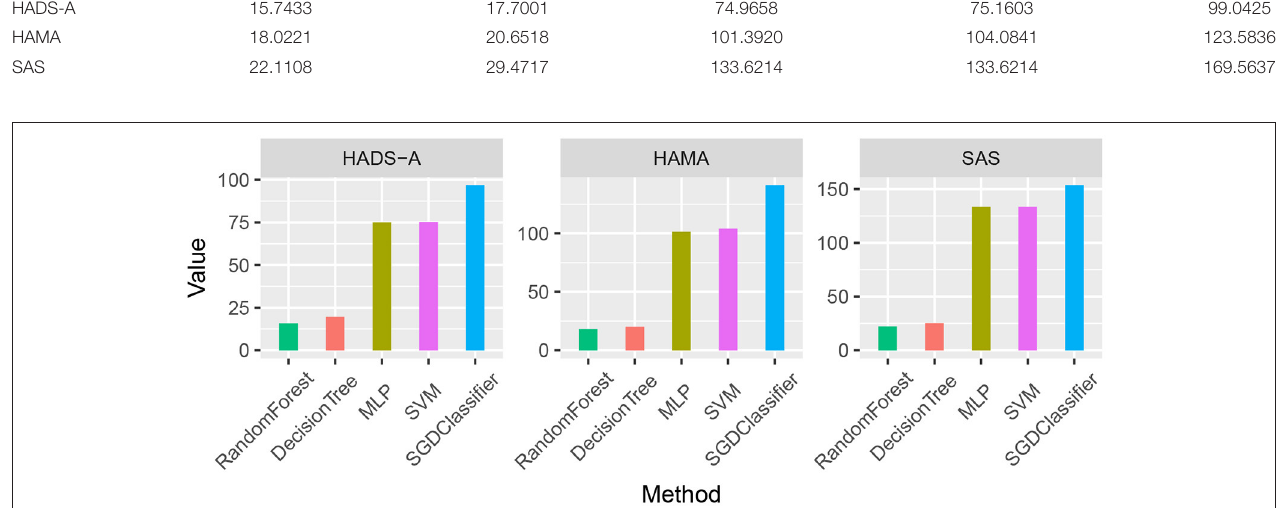
study also found that chronic physical diseases is an identified factor significantly associated with post-stroke mental health (Almhdawi et al., 2020). Interestingly, our study found that the level of HDL-C is independent protective factors